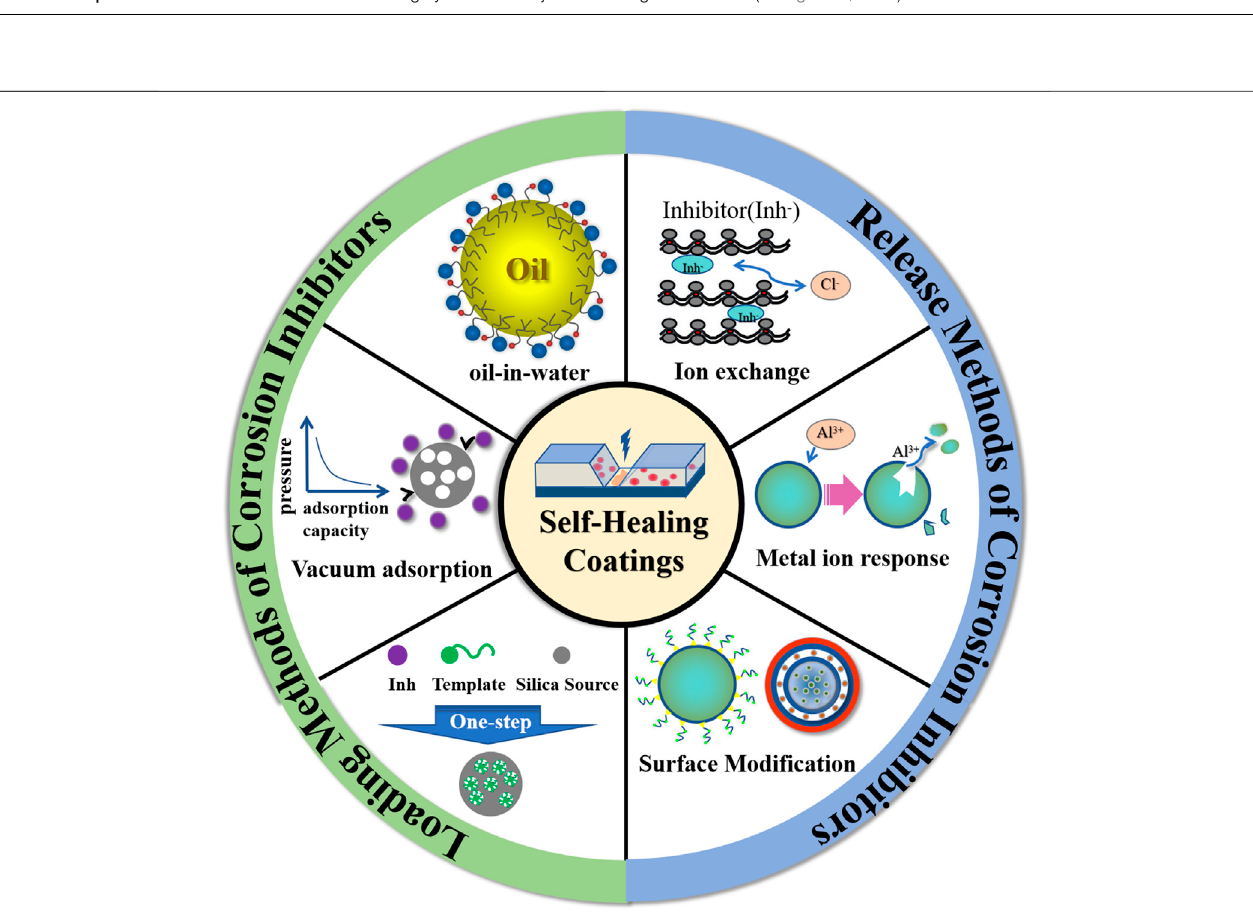
FIGURE 2 | Overview of main loading and release methods of corrosion inhibitors in this